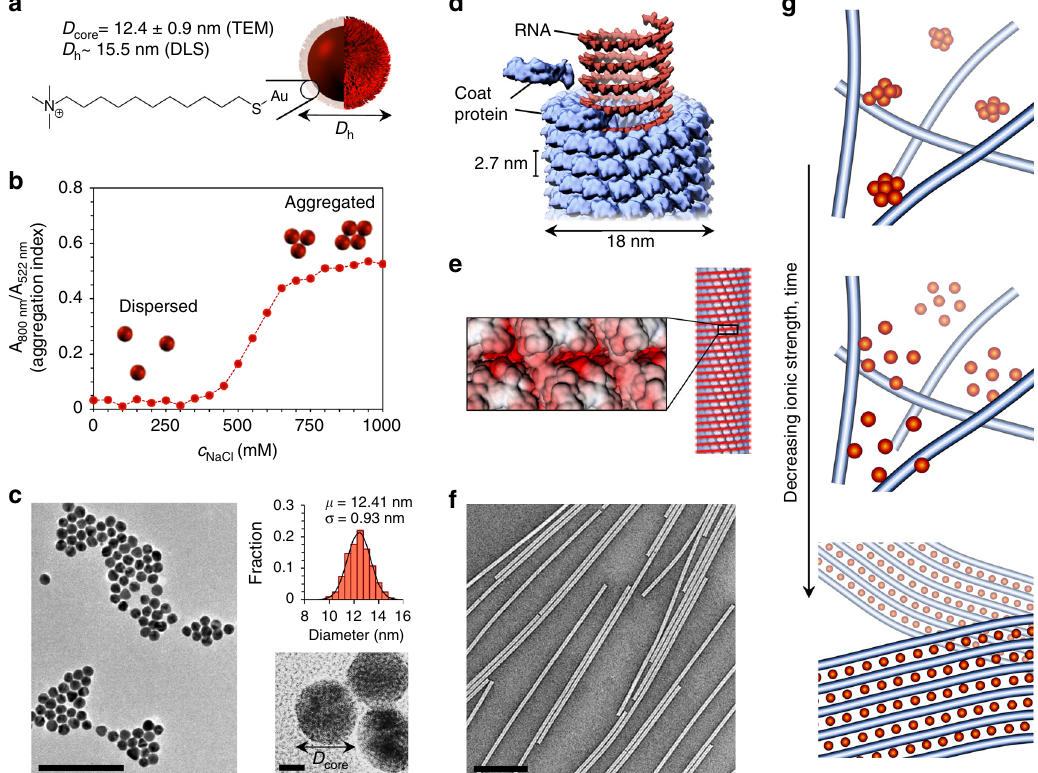
Fig. 1 Structural details of the oppositely charged colloids and their electrostatic self-assembly upon dialysis. a Details of the used gold nanoparticles and chemical structure of the cationic ligand. b Colloidal stability of the AuNPs shown as the aggregation index, which is a function of the ionic strength, characterized by UV – vis spectrometry. The aggregation index is de fi ned here as A 800 nm / A 522 nm . c TEM image of AuNPs and the AuNP size distribution from 205 particles. d Schematic of the structural details of TMV. e The electrostatic surface potential map of TMV in aqueous solution shows that TMV surface charge distribution has a helical symmetry. f TEM micrograph of the TMV nanorods. g Schematic illustration of the formation of the binary assemblies as a function of the ionic strength. Scale bars : 100 nm and 5 nm in c and 200 nm in